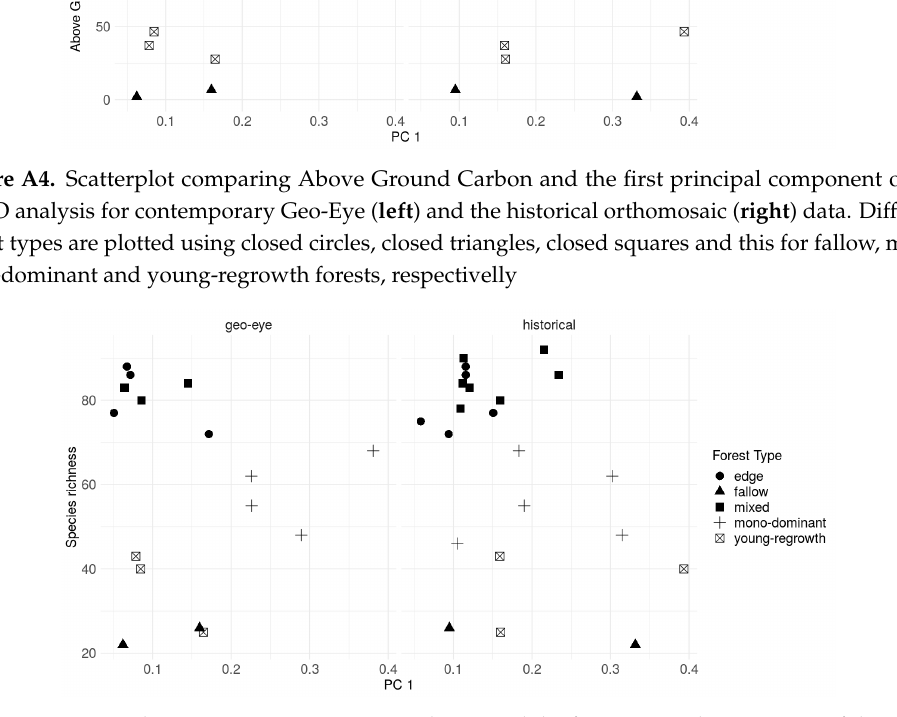
Figure A5. Scatterplot comparing tree species richness and the first principal component of the FOTO analysis for contemporary Geo-Eye ( left ) and the historical orthomosaic ( right ) data. Different forest types are plotted using closed circles, closed triangles, closed squares and this for fallow, mixed mon-dominant and young-regrowth forests, respectivelly